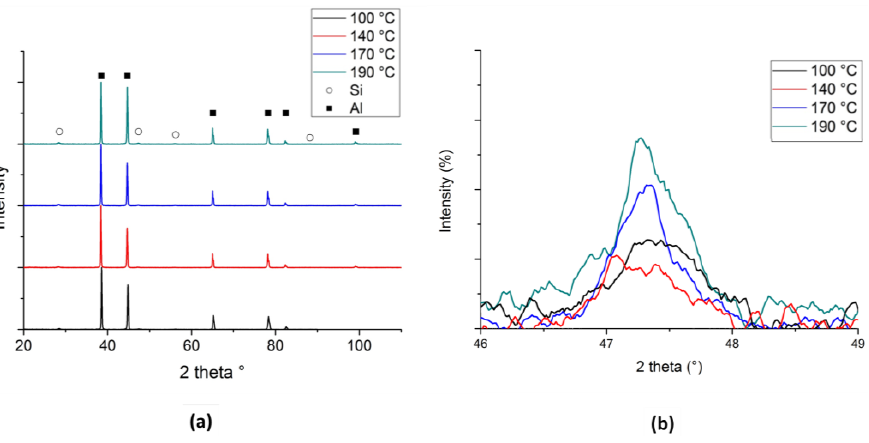
Figure 3. ( a ) X-ray diffraction patterns of the sample cross-sections; and ( b ) detail of Si (111) peaks.